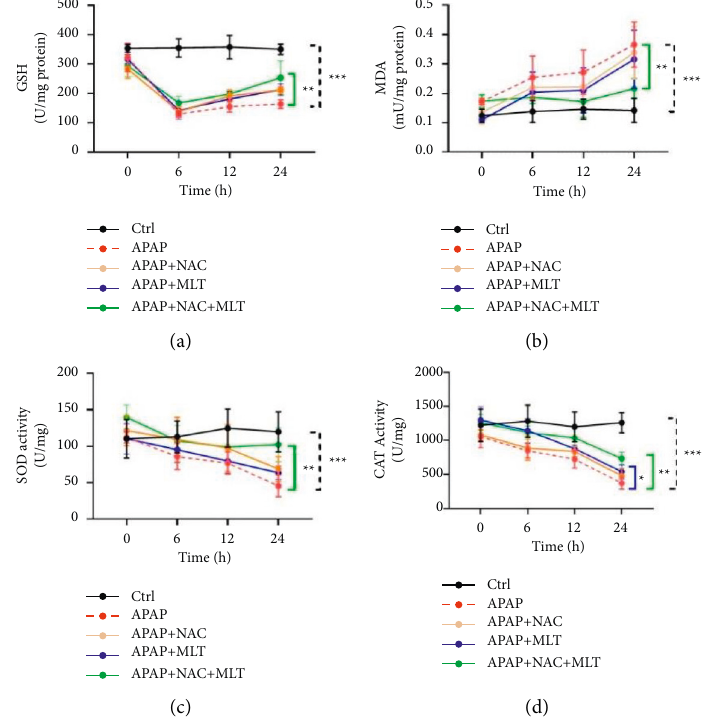
Figure 3: The effect of MLT, NAC, and combined treatments on glutathione (GSH) (a), malondialdehyde (MDA) (b), superoxide dismutase (SOD) and (c), catalase (CAT) activities levels (d) at an indicated time. The columns are shown as means ± SD ( n � 5). ( ∗ p < 0 . 05, ∗∗ p < 0 . 01, ∗∗∗ p < 0 .